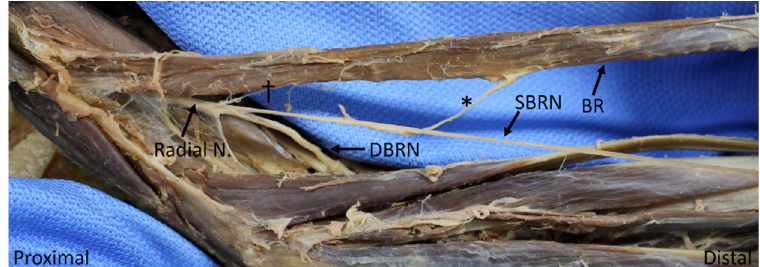
Figure 1. Nerve to the brachioradialis (BR) arising from the superficial branch of a radial nerve (*), with an additional smaller branch arising from the radial nerve proper (†). BR: brachioradialis; SBRN: superficial branch of the radial nerve; DBRN: deep branch of the radial nerve.